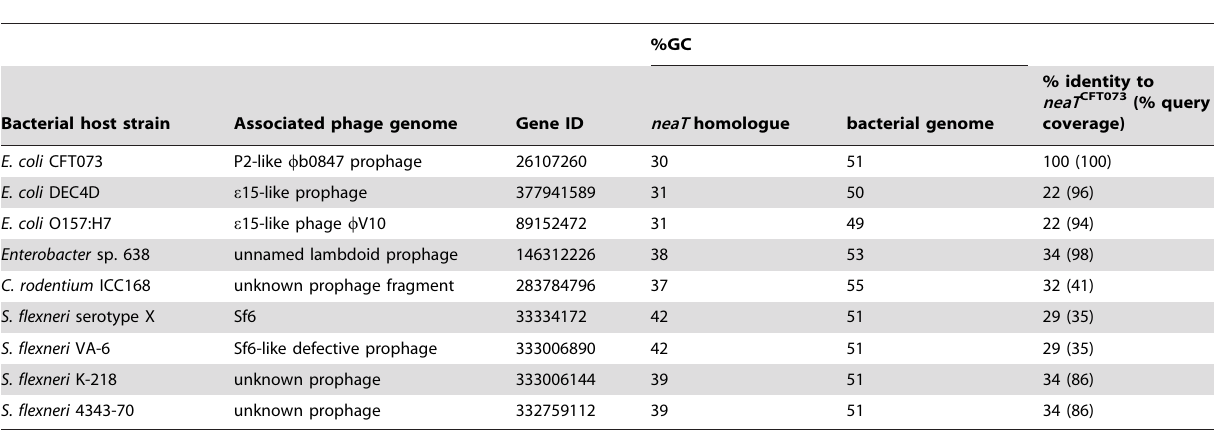
Table 2. neaT homologues associated with